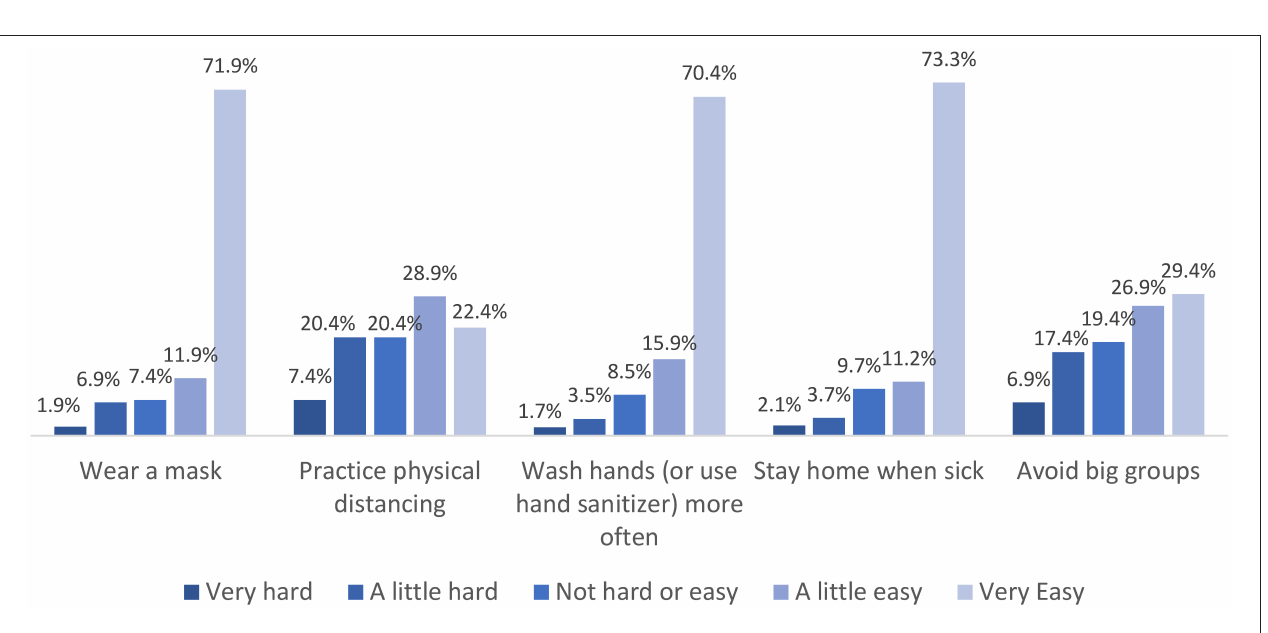
most of the time, 31% reported feeling safe some of the time, and 8% never felt